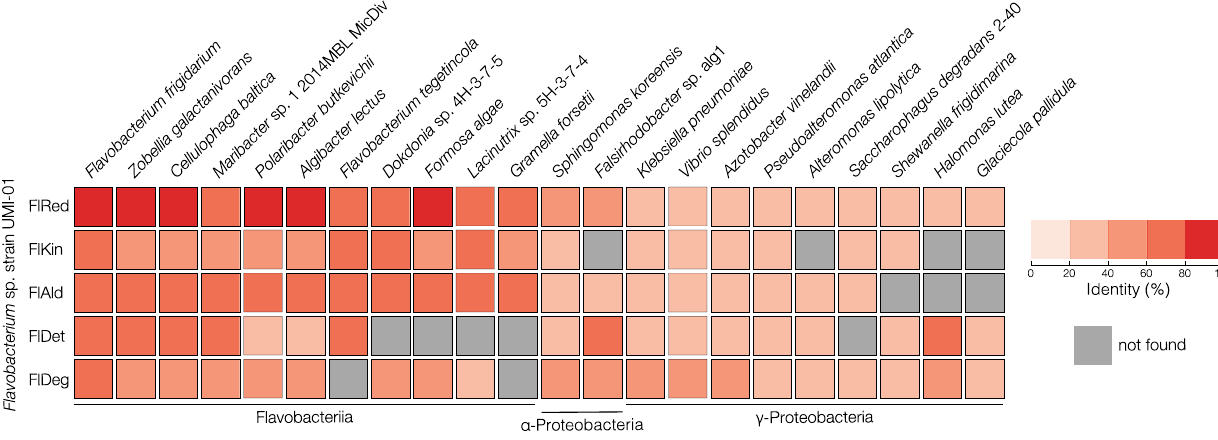
Fig. 6 Enzymes involved in DEHU metabolism of strain UMI-01 and their homologous enzymes in other alginate-assimilating bacteria. A BLASTP search was performed using the amino acid sequence of each enzyme of strain UMI-01 as the